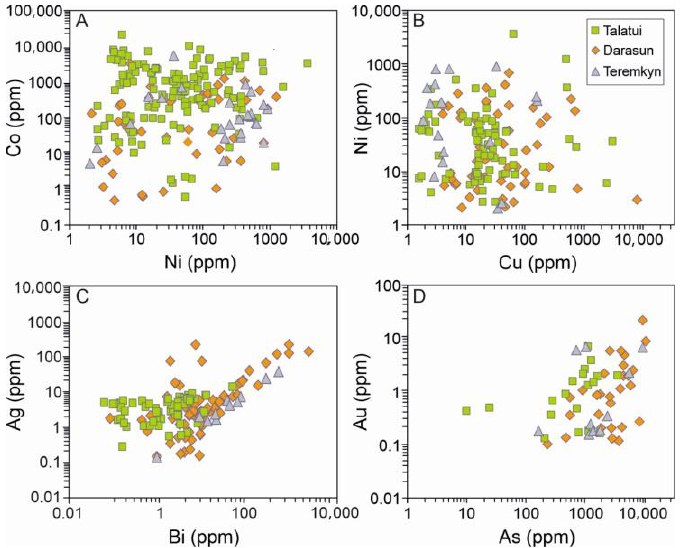
Figure 6. Multi-element diagram for pyrite (Py) from the Talatui, Teremkyn, and Darasun ores, normalized to the bulk continental crust [34]. GM—geometric means (Table 2) calculated from data presented in Table S2.